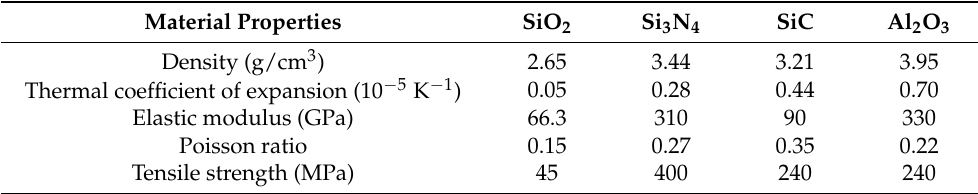
Table 2. Material properties of diffusion barrier layer of the biocompatible package *. Material